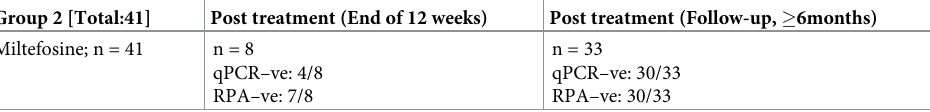
Table 6. Performance analysis of qPCR and RPA assays for PKDL following completion of treatment. Group 2 [Total:41] Post treatment (End of 12 weeks) Post treatment (Follow-up, � 6months) Miltefosine; n =